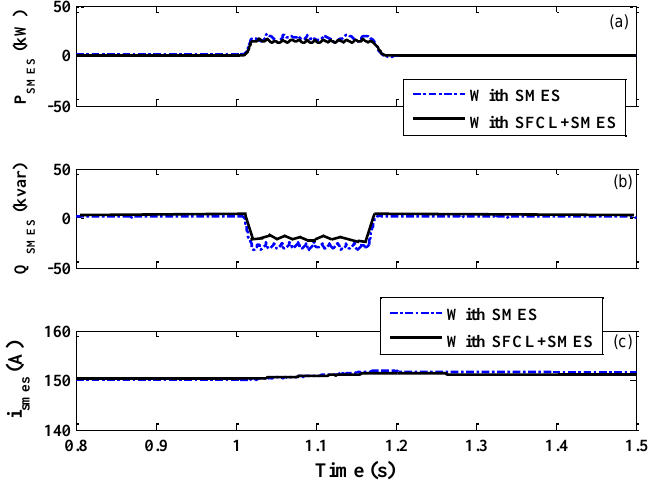
Figure 20. Simulation results of the SMES unit under the asymmetrical fault. ( a ) active power; ( b )